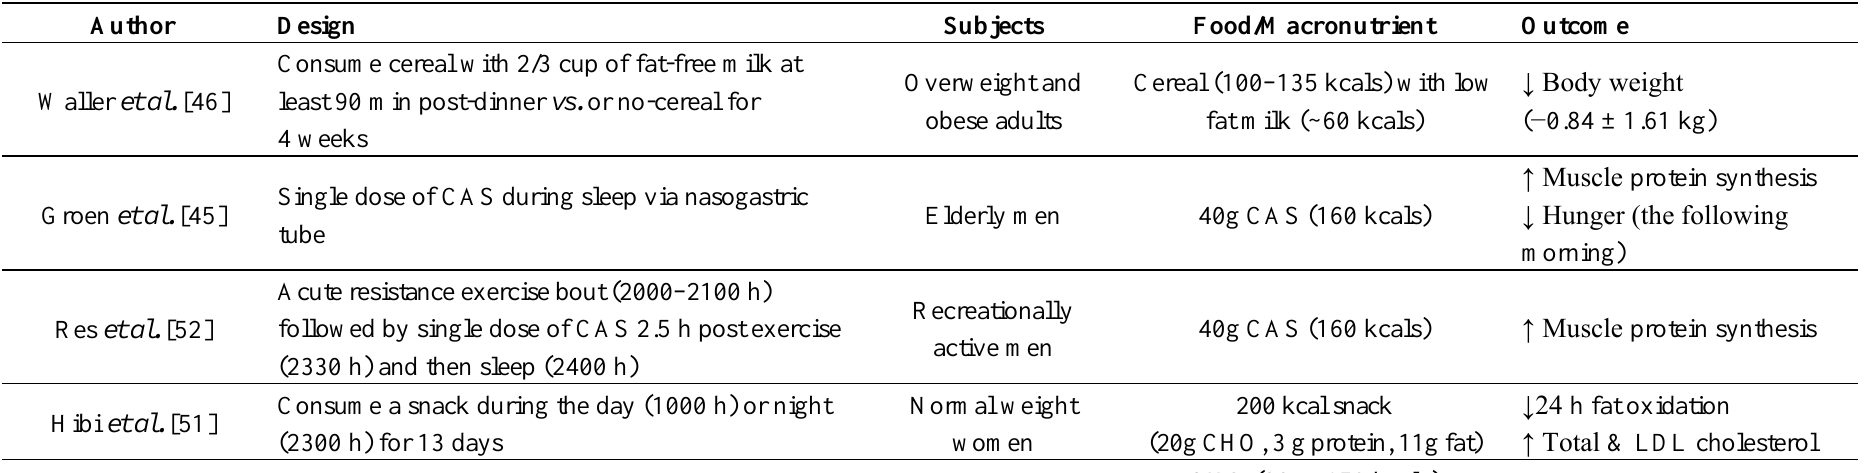
Table 1. Effects of small meals/snack consumed at